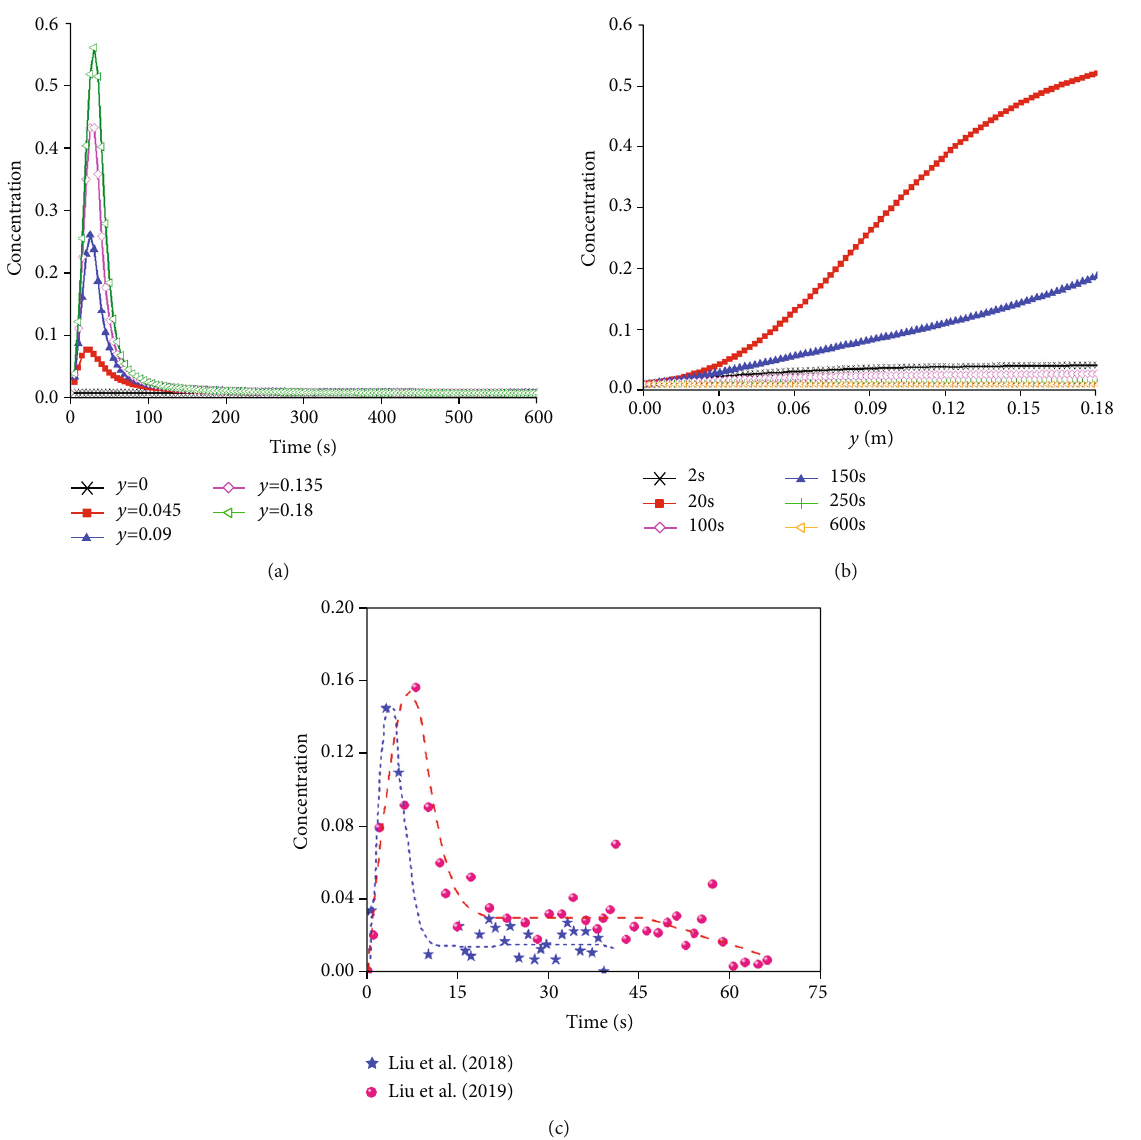
Figure 4: Evolution of concentration of fl uidized particles: (a) over time, (b) with space, and (c) experimental results from